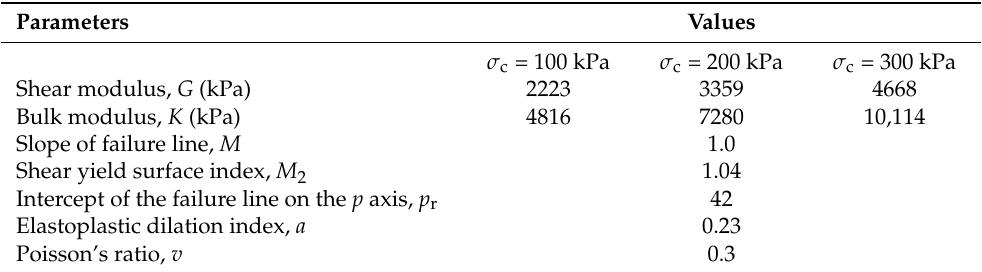
Table 1. Parameter values for the proposed elastoplastic model with N FT = 3 used in [36].